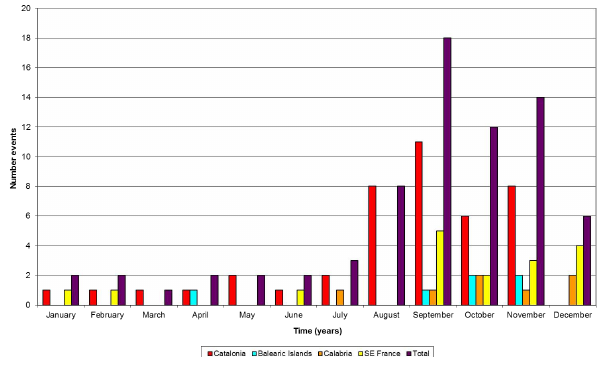
Fig. 6. Interannual evolution of catastrophic floods for the period 1981–2010.